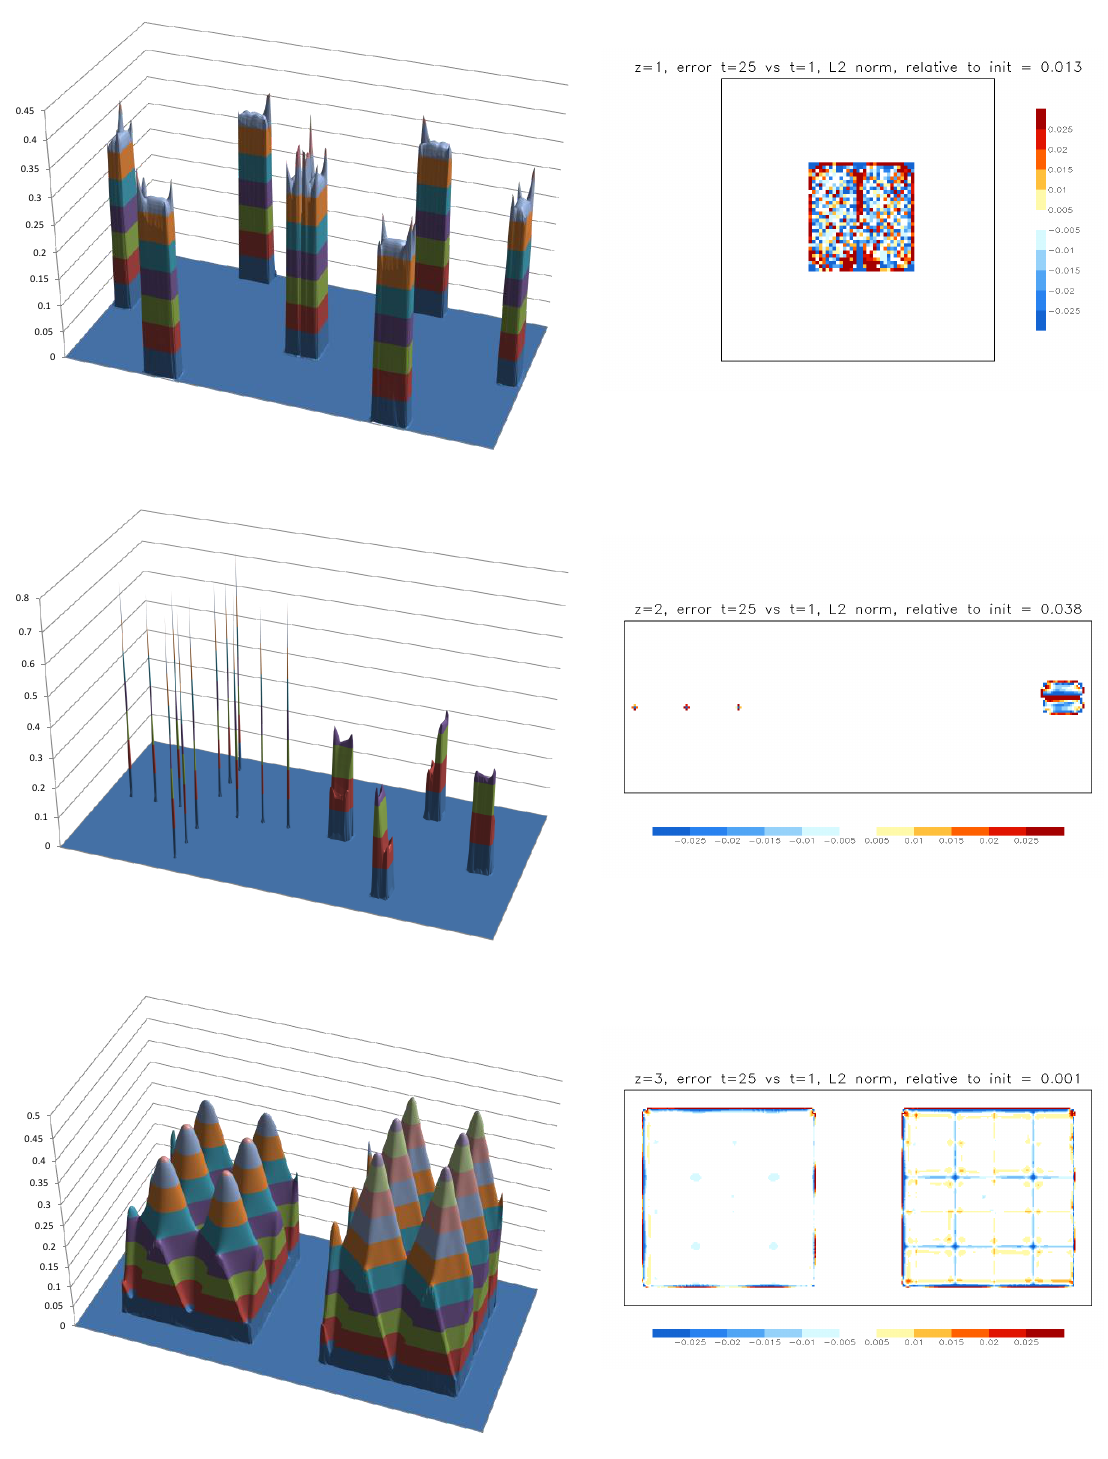
Figure 7. Double-vortex rotation tests for a rectangular split between the vortices (upper panels); three single-cell peaks and two connected rectangles (middle panels); and sin- and cone-shaped surfaces (lower panels). A series of time steps is shown in the left panels, except for the low panel (shown t = 361). Right panels: error field after one full revolution (obs 10-fold more sensitive scale and relative L 2 norm given above each plot). Max Courant ∼ 1.5. Grid dimensions 400 × 200. Without